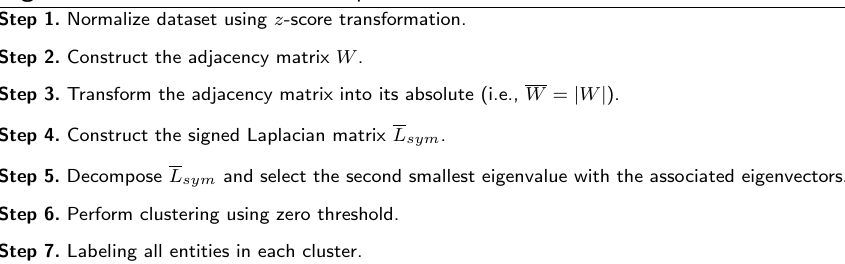
Algorithm 2 Zero threshold based spectral classifier.